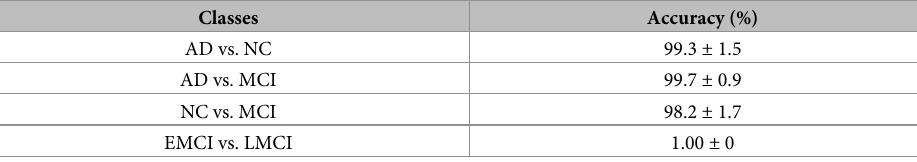
Table 3. Binary classification result accuracies (mean ± standard